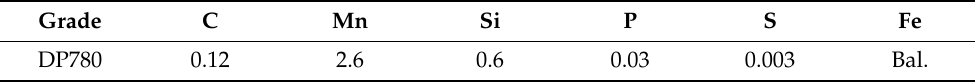
Table 1. Chemical composition (wt.%) of DP780 steel.